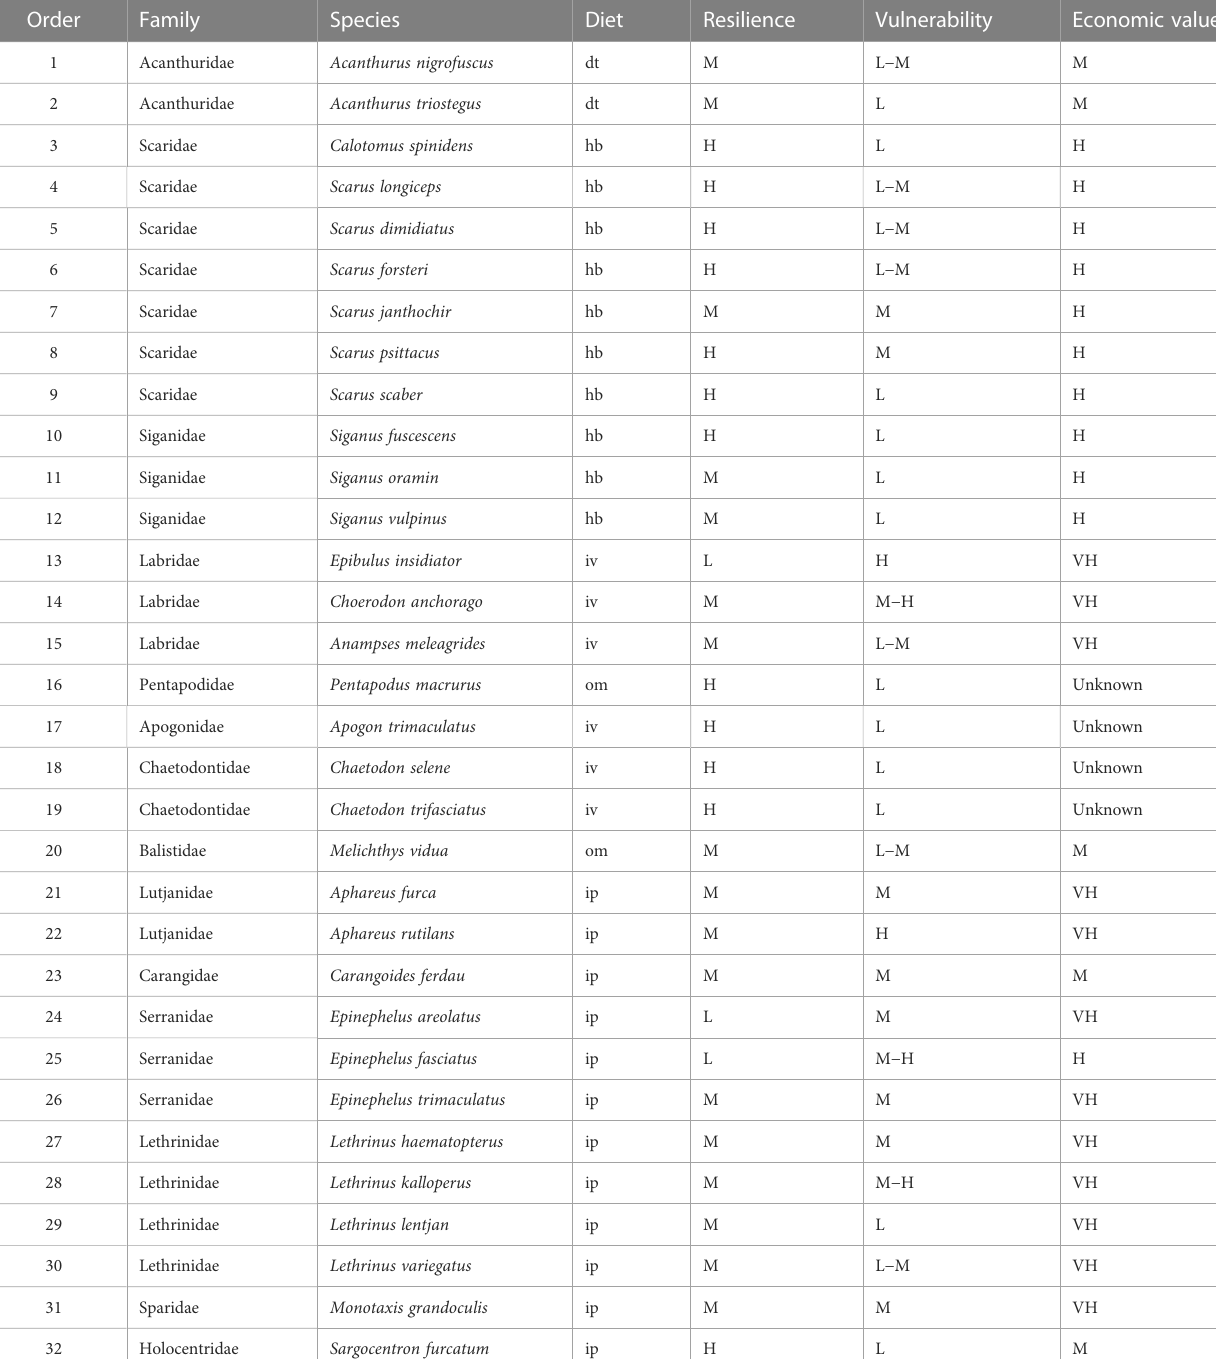
TABLE 3 32 fi sh sampled in 1998 — 1999 from the lagoon of Meiji Reef were not detected in 2012 — 2018.